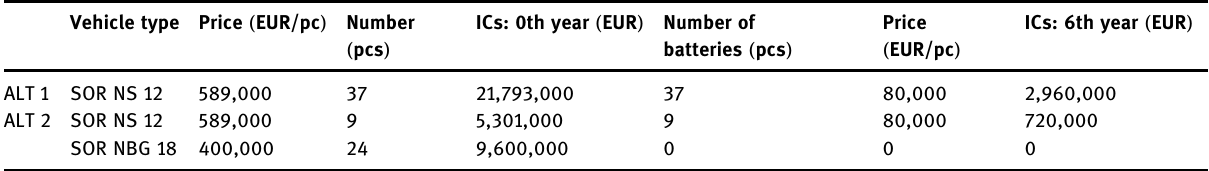
Table 4: One - o ff ICs for individual alternatives Vehicle type Price ( EUR/pc ) Number